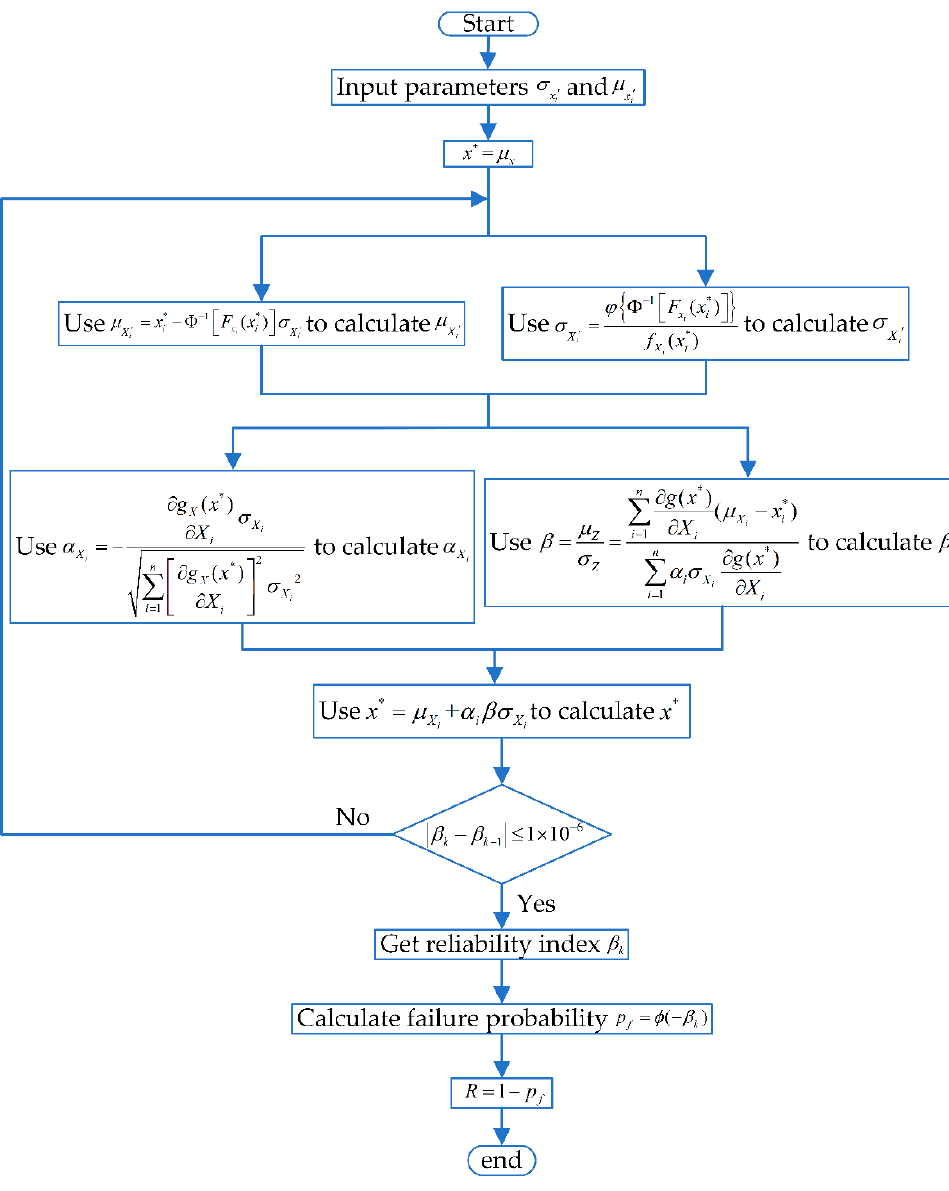
Figure 8. Calculation flowchart of the Joint Committee on Structure Safety method (known as the JC method).